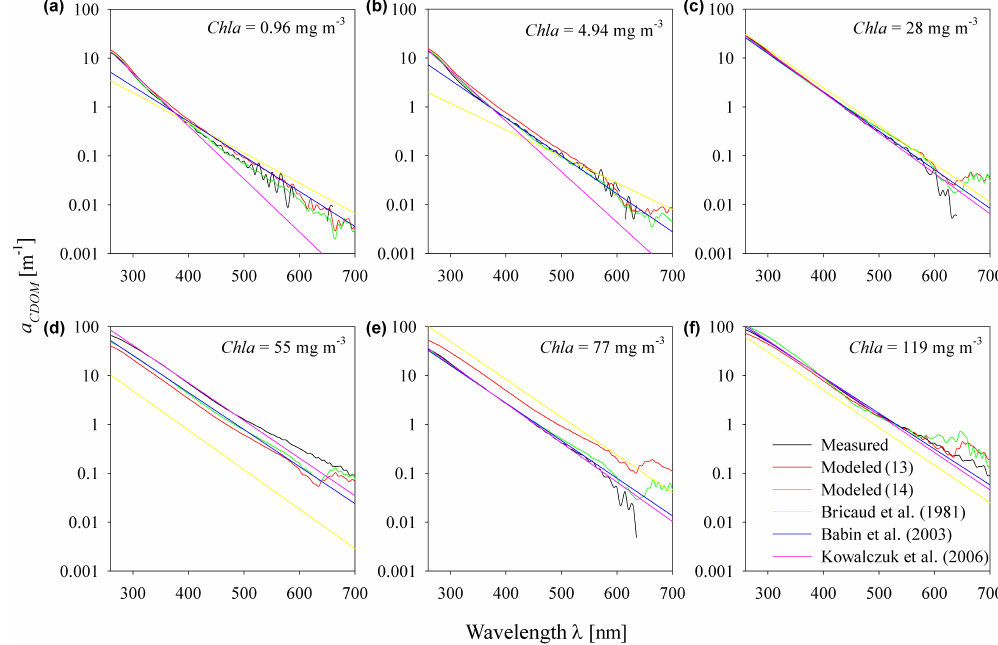
Figure 10. CDOM light absorption spectra (empirical, modeled using Eqs. (13) and (14), calculated using the models of Bricaud et al. (1981), Babin et al. (2003) and Kowalczuk et al. (2006) for the following concentrations of chlorophyll a Chl a : (a) 0.96mgm − 3 ; (b) 4.94mgm − 3 ;